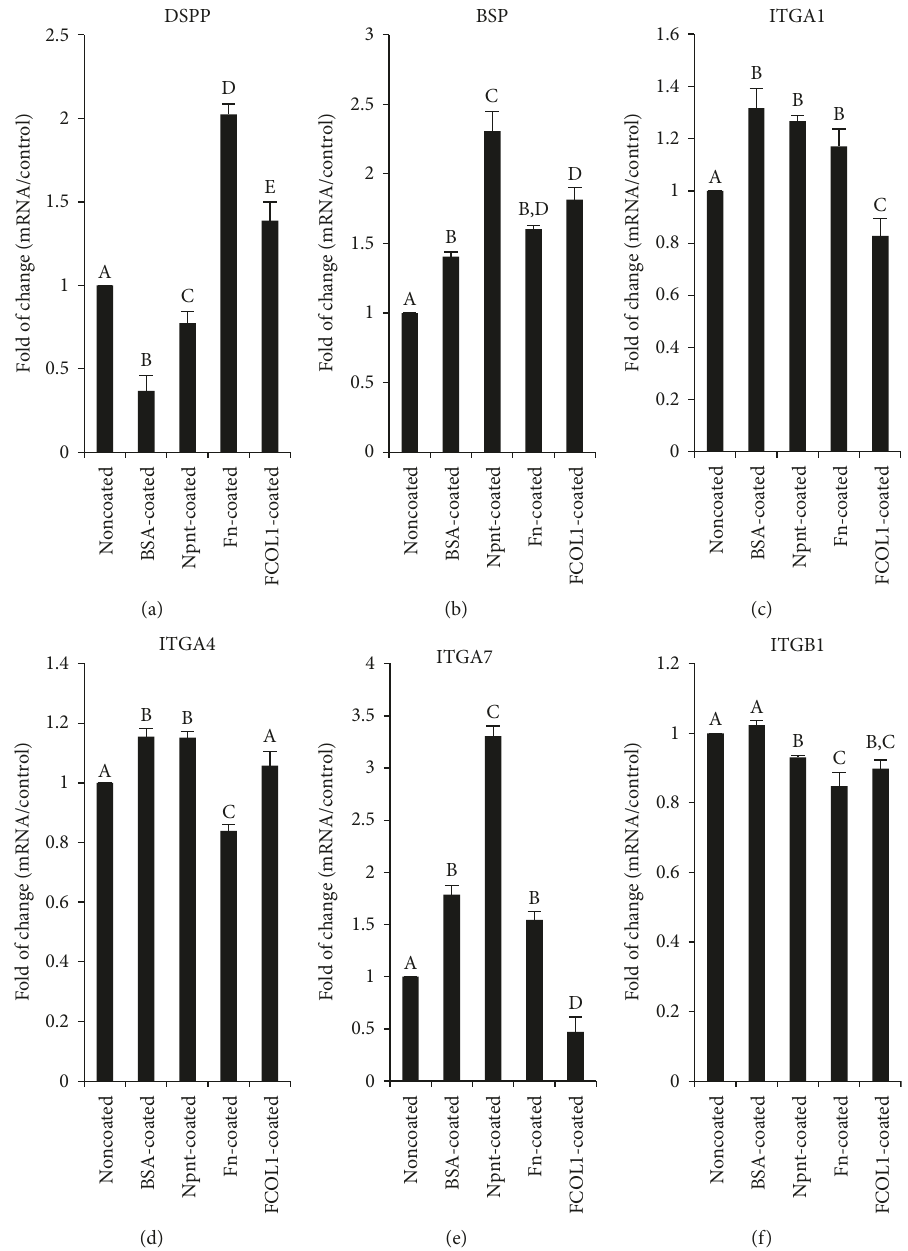
Figure 7: Real-time RT-PCR of DSPP, BSP, and integrins on day 28. hDPSCs (passage number 4) were cultured in di ff erent substrate(s) in DMEM supplemented with 10% FBS for fi ve days. Mineralization reagent including β -GP and AA was incorporated on day fi ve. Dexamethasone (100nM) (D2915, Sigma) was started to be added on day nine. The total culture time was 28 days. DSPP (a), BSP (b) and ITGA1 (c), ITGA4 (d), ITGA7 (e), and ITGB1 (f) mRNA expression was investigated. Di ff erent symbols represent signi fi cant di ff erences, p < 0 01 (except for p < 0 05 between noncoated and Npnt-coated in (a); noncoated and BSA-coated and BSA-coated and FCOL1-coated in (b); noncoated and Fn-coated and noncoated and FCOL1-coated in (c); BSA-coated and FCOL1-coated in (d); noncoated and Fn-coated in (e); and noncoated and Npnt-coated in (f)) by post hoc Tukey ’ s HSD